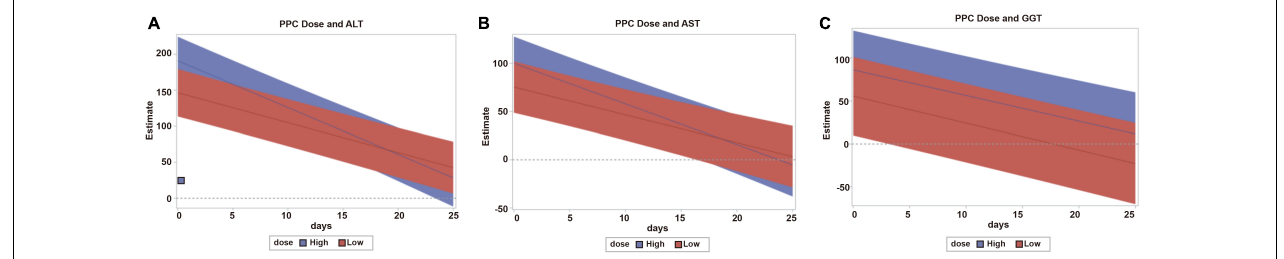
FIGURE 3 | Comparison of the trajectories of high-dose and low-dose PPC treatment. (A) Dose effect on ALT change. (B) Dose effect on AST change. (C) Dose effect on GGT change. PPC, polyene phosphatidylcholine; ALT, alanine aminotransferase; AST, aspartate aminotransferase; GGT, γ -glutamyl transferase; high dose, 930 mg PPC/day; low dose, <930 mg PPC/day.